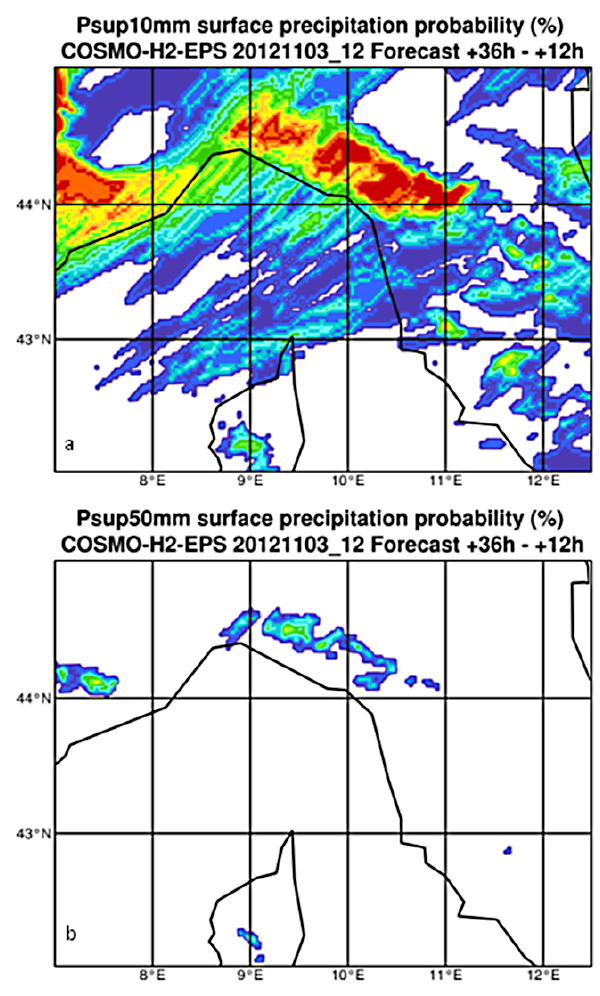
Figure 26. COSMO-H2-EPS ensemble forecasts: (a) precipita- tion probability above 10mm; (b) precipitation probability above